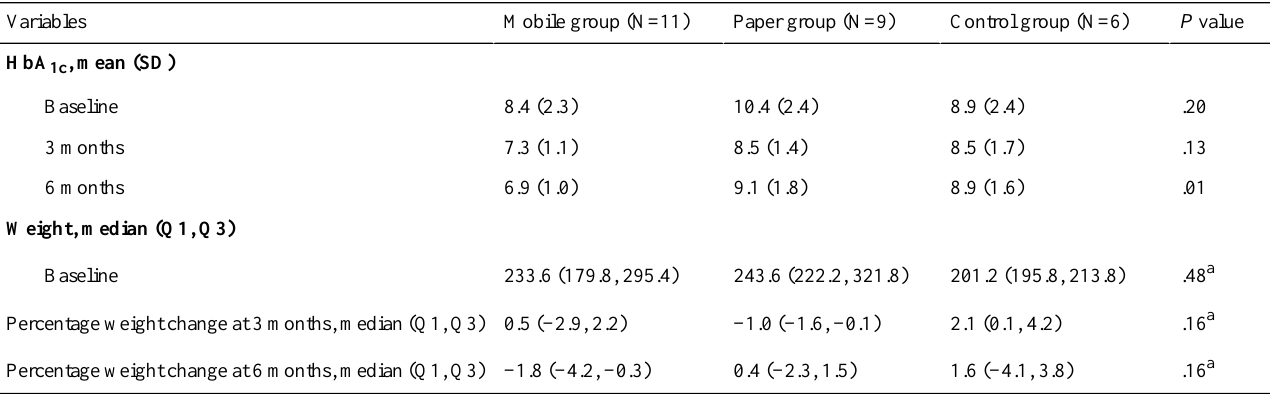
Table 3. Descriptive values for weight and glycated hemoglobin (HbA 1c ) levels at each visit by group. Q1: 25 th percentile; Q3: 75 th